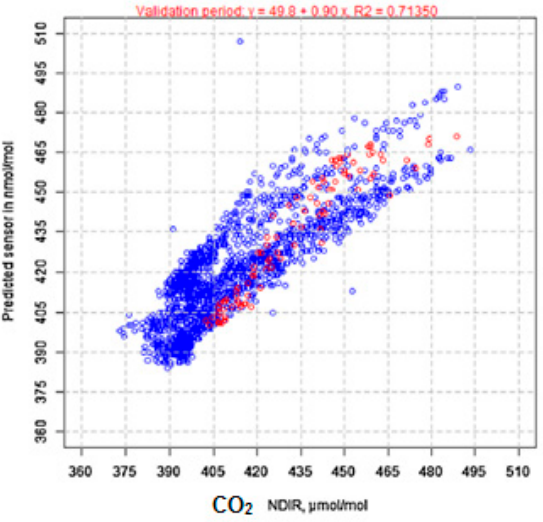
Figure 8. Red points indicate measured data, and blue indicate simulated data. Reproduced with permission from Reference [23]. NDIR: non-dispersive infrared technology.